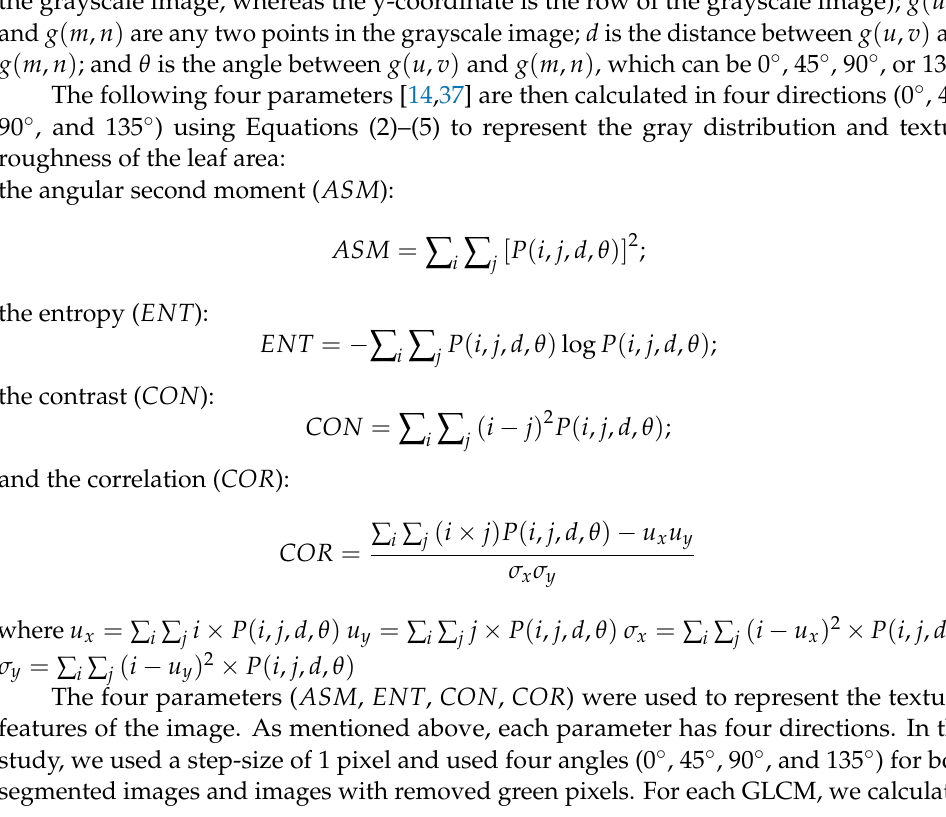
Figure 4. Flowchart of image